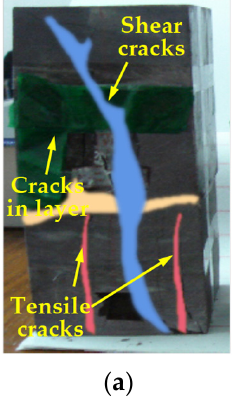
Figure 9. Fracture distribution of gray samples under vertical loading: ( a ) No. 1 sample; ( b ) No. 2 sample; ( c ) No. 3 sample; ( d ) No. 4 sample.